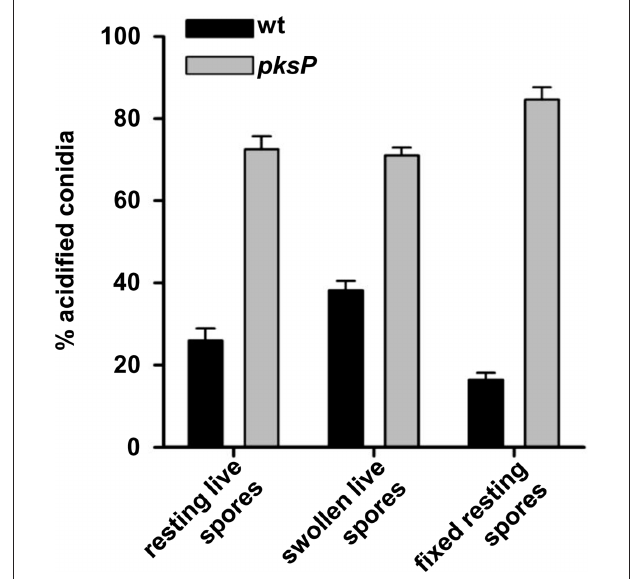
FiguRe 5 | Swelling of conidia affects phagolysosomal acidification. Resting conidia, swollen conidia or formaldehyde-fixed conidia of the wild type or the pksP mutant were subjected to MH-S coincubation. The percentage of intracellular conidia residing in acidified phagolysosomes after ingestion by MH-S cells was estimated. Values represent the mean + SD of three experiments.